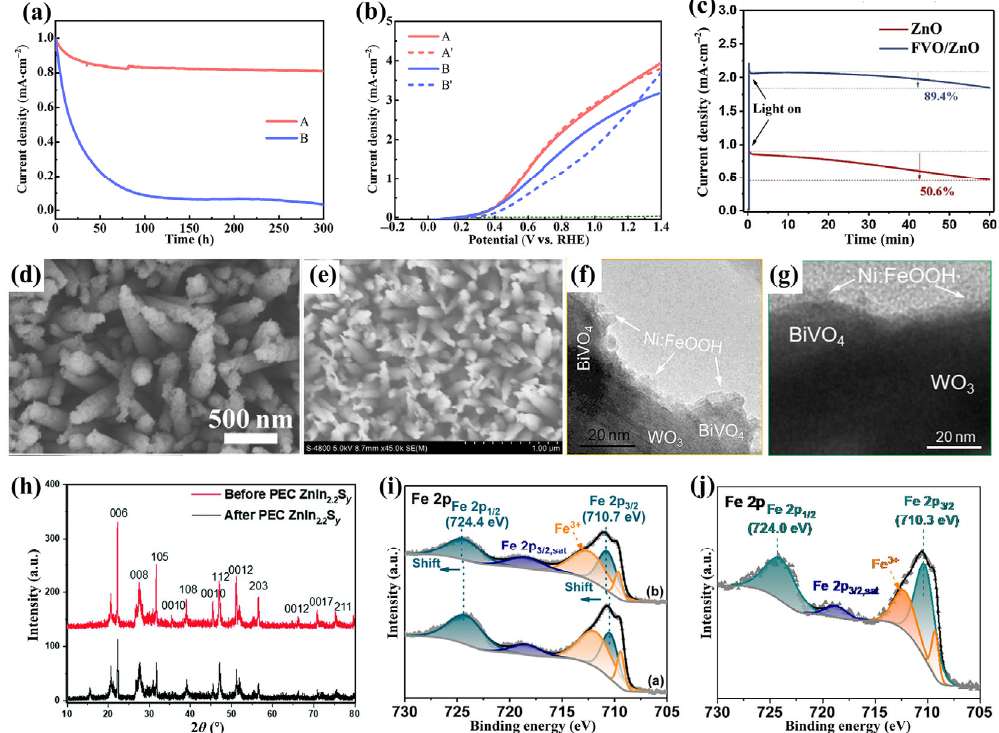
Figure 3 (a) I – T curves of different samples (A: better stability, B: poor stability). (b) J – V curves before and after PEC testing (A and B: initial sample, A’ and B’: after PEC testing). (c) I – T curves of pure ZnO and FVO/ZnO NR photoanodes under illumination for 60 min at a constant potential of 1.2 V vs. RHE. Top-view SEM images of the FVO/ZnO NR array (d) before and (e) after the PEC measurement. Reproduced with permission from Ref. [54], © Elsevier B.V. 2019. TEM images of the Ni:FeOOH-coated WO 3 /BiVO 4 core/shell NW (f) before and (g) after the stability test. Reproduced with permission from Ref. [55], © American Chemical Society 2016. (h) XRD patterns of ZnIn 2.2 S y before and after the PEC test. Reproduced with permission from Ref. [57], © The Royal Society of Chemistry 2019. The XPS of FeCo-MOF/Fe 2 O 3 photoanode (i) before and (j) after the stability test for 5 h. Reproduced with permission from Ref. [62], © Elsevier B.V.